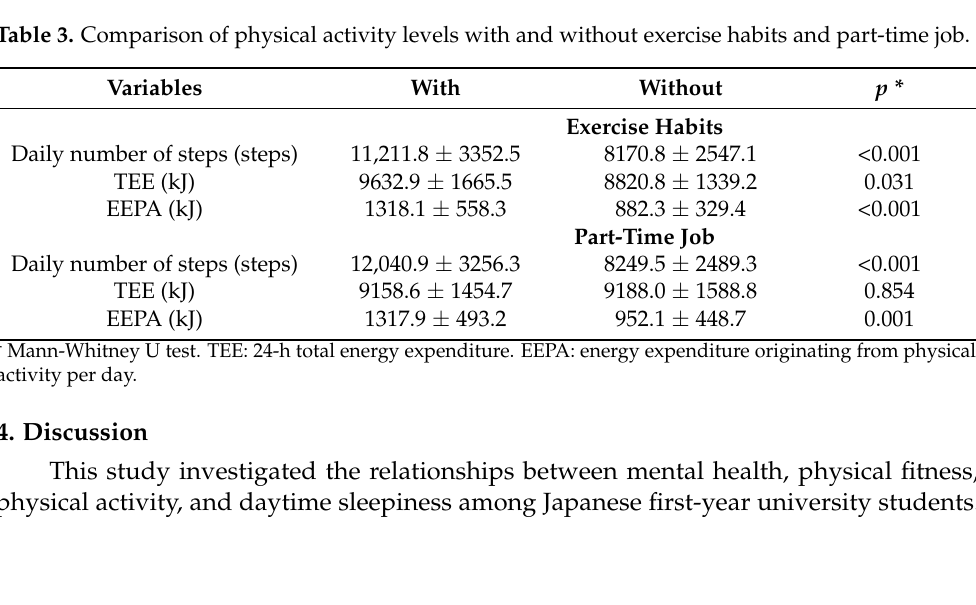
Table 2. Comparison of PHQ-9 scores with and without part-time job and exercise habits. Part-Time Job Exercise Habits